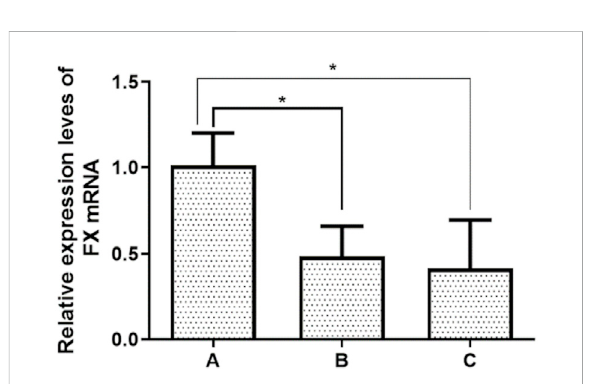
FIGURE 4 Expression levels of FX miRNA. * p < 0.05 vs. A; ** p < 0.01 vs. A.